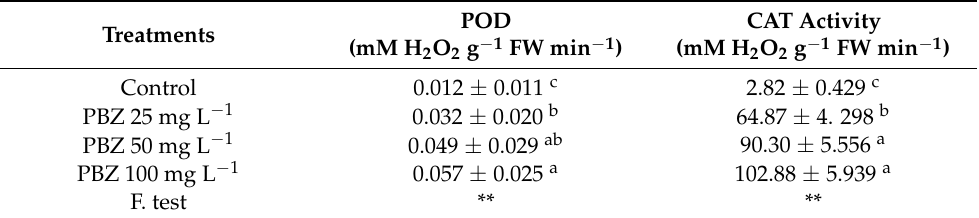
Table 5. Impact of applied treatments on enzyme activities (catalase, CAT, peroxidase, and POD) after 10 days form PBZ foliar application (after 10 days from PBZ application and without infection by Alternaria solani